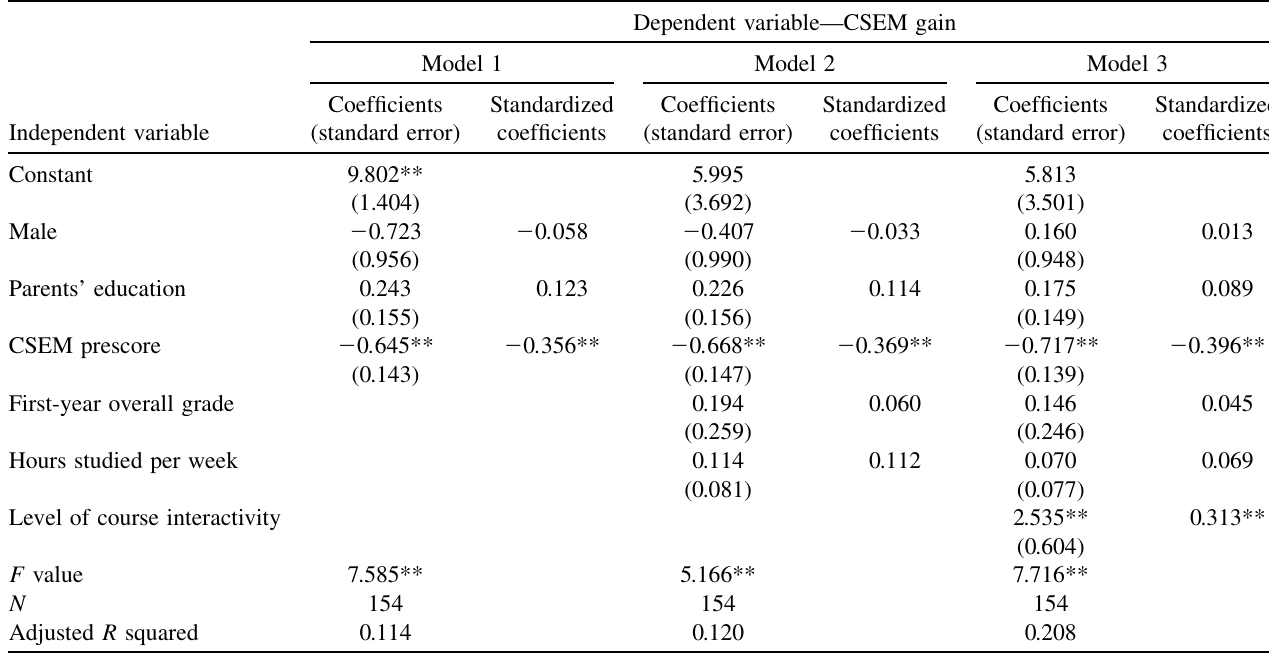
TABLE IV. CSEM—Models 1–3 (* p < 0 : 05 , ** p < 0 : 01